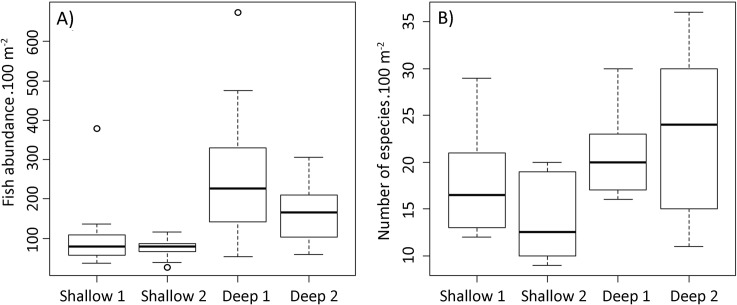
Reef fish abundance (A) and species richness (B) on shallow and deep reefs in northeastern Brazil. Box plots show the interquartile range, with whiskers indicating the respective confidence intervals. The horizontal lines indicate median values and circles represent the outliers of the total length that presented greater variability.